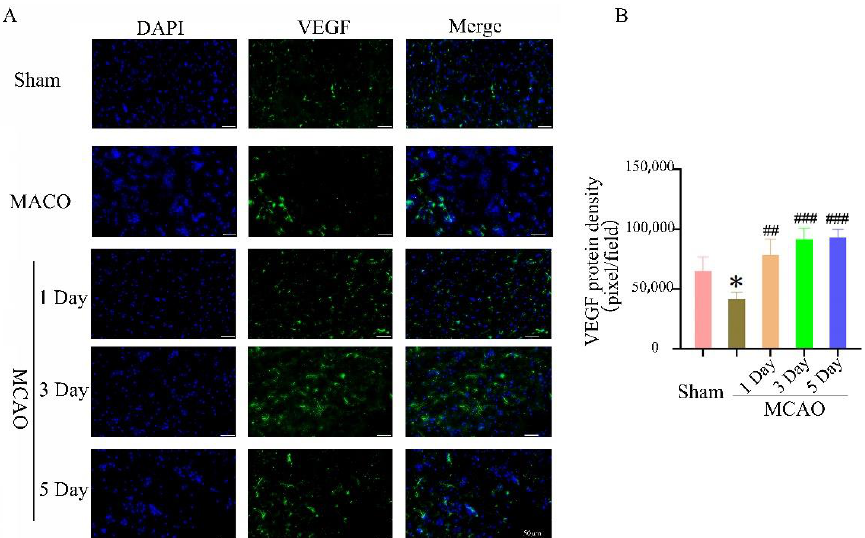
Figure 3. The expression of vascular endothelial growth factor were detected by immunofluorescence method follow middle cerebral artery occlusion and treadmill exercise. ( A ) The expression levels of vascular endothelial growth factor were detected with immunofluorescence in mouse brain with middle cerebral artery occlusion and treadmill exercise 1D, 3D, and 5D; bars: 50 µ m; ( B ) Quantitative analysis of the expression level of a vascular endothelial growth factor in ( A ). (* p < 0.01 vs. Sham; ## p < 0.01, ### p < 0.001 vs. MCAO, n = 3).